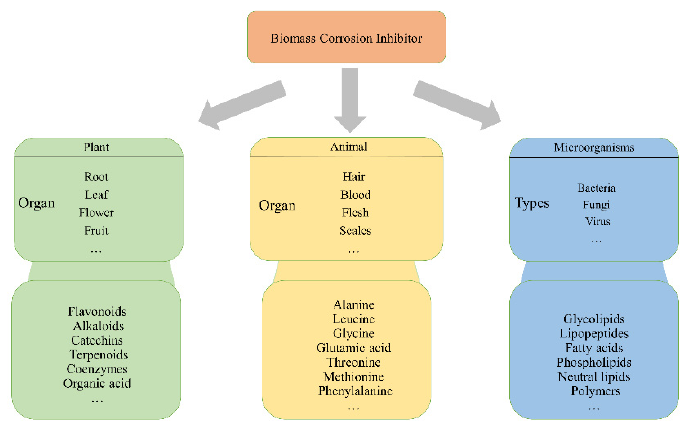
Figure 1. Schematic diagram of the source of biomass corrosion inhibitors.